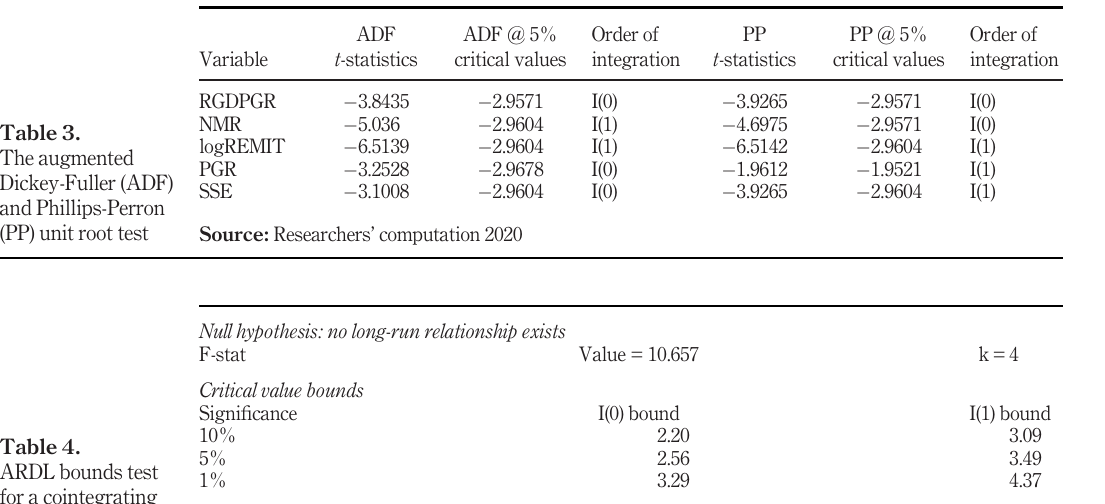
for a cointegrating